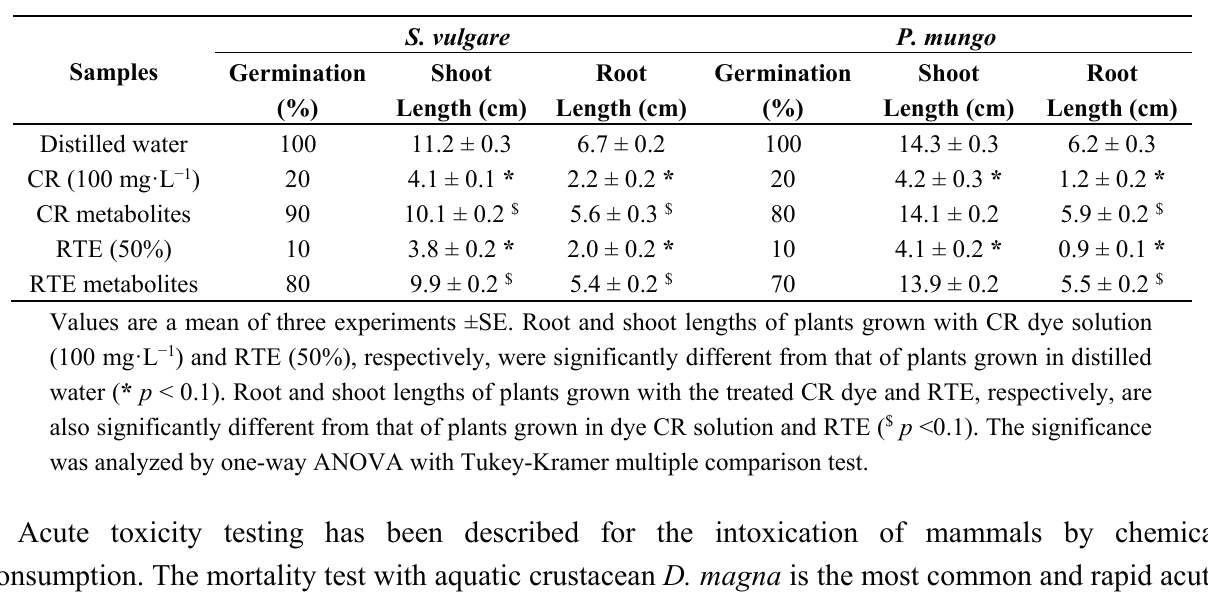
their treated samples using PUF-immobilized microbial consortium in an upflow column